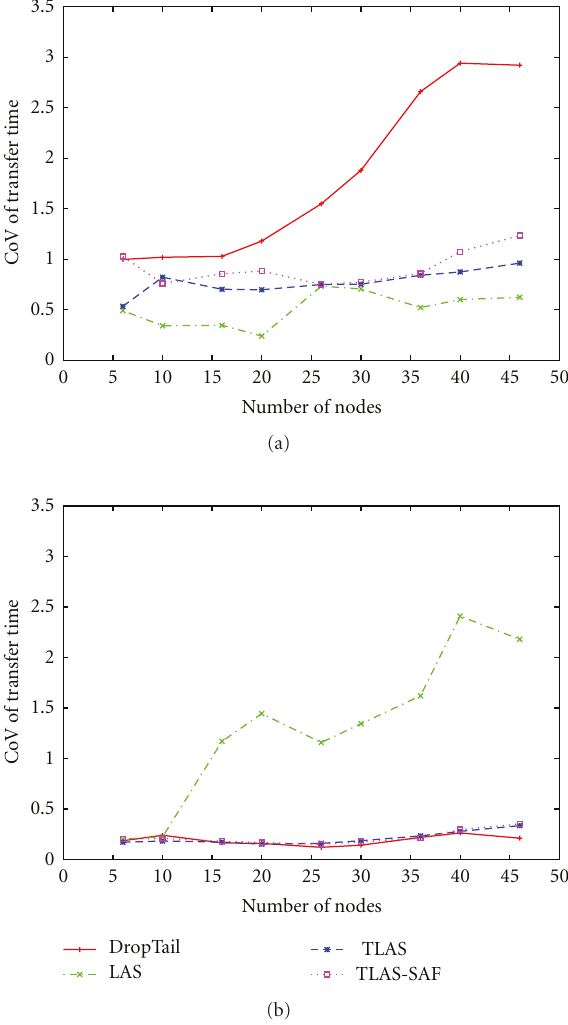
Figure 7: CoV of transfer time under TLAS-SAF and other studied policies (short flows inter-arrival time = 1 second): (a) small files. (b) large